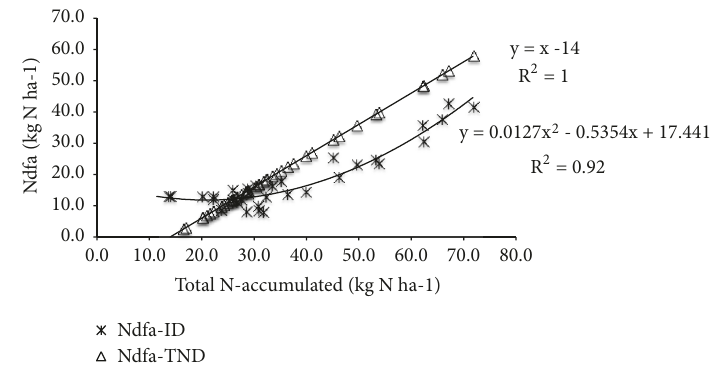
Figure 3: Relationships between total N yields of cowpea genotypes and N derived from the atmosphere as affected by the isotopic dilution (Ndfa-ID) and total N difference (Ndfa-TND) methods.